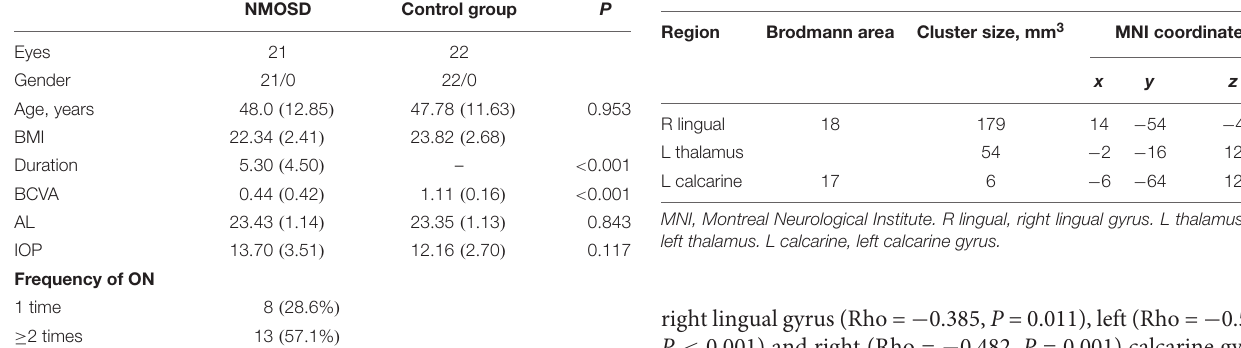
TABLE 1 | Demographics and clinical information. TABLE 2 | Group differences between individuals with neuromyelitis optica spectrum disorder (NMOSD) and controls.